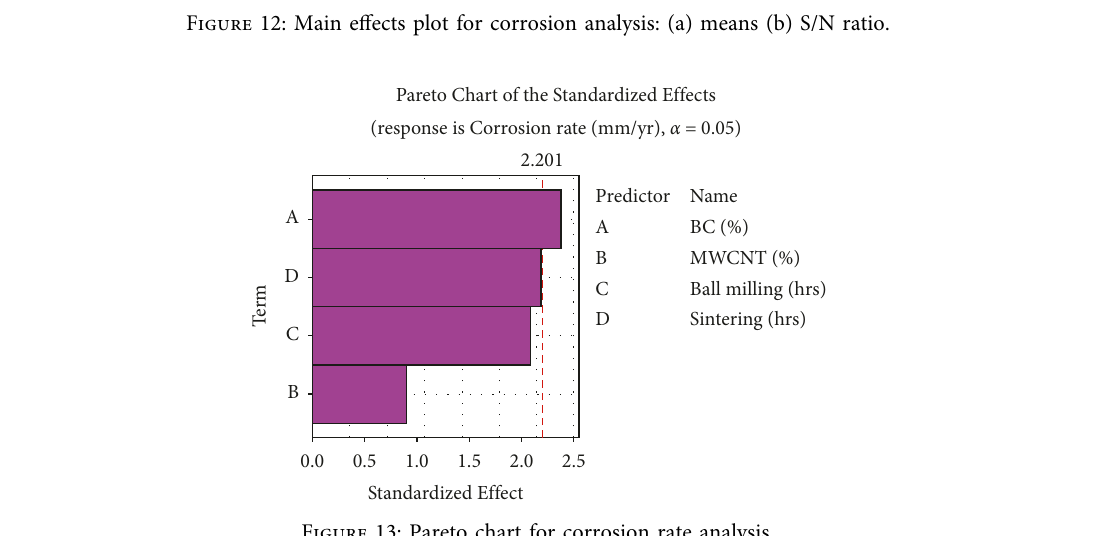
Figure 13: Pareto chart for corrosion rate analysis. Table 12: Analysis of variance for corrosion